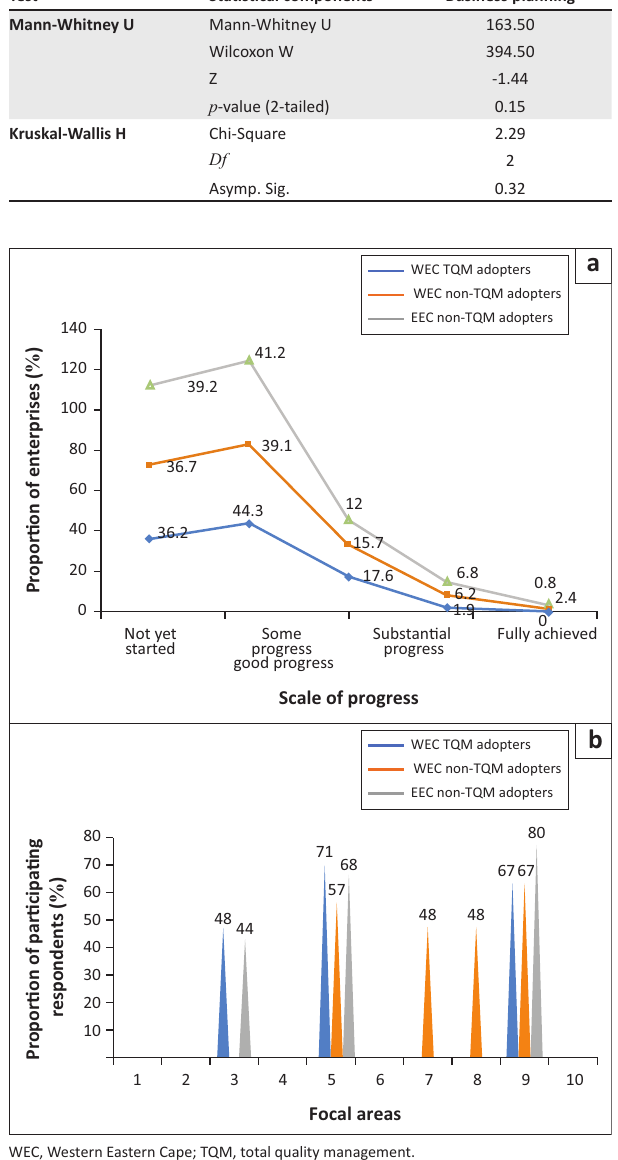
FIGURE 4: The respondents’ (a) scale of progress made in business planning (b) most critical focal areas for improvement in ‘business planning’.